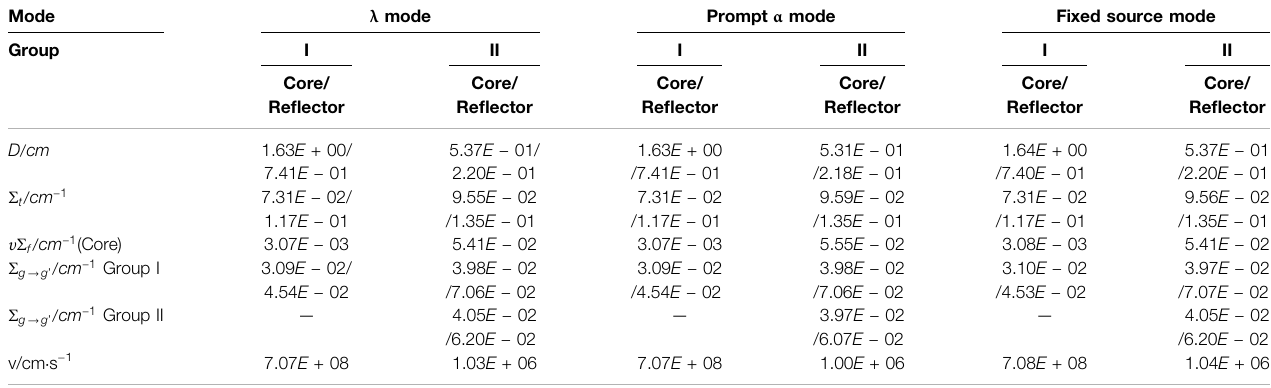
TABLE 3 | Homogeneous and condensate parameters of core/re fl ector in ADSR (k eff (cid:2) 0.96). Mode